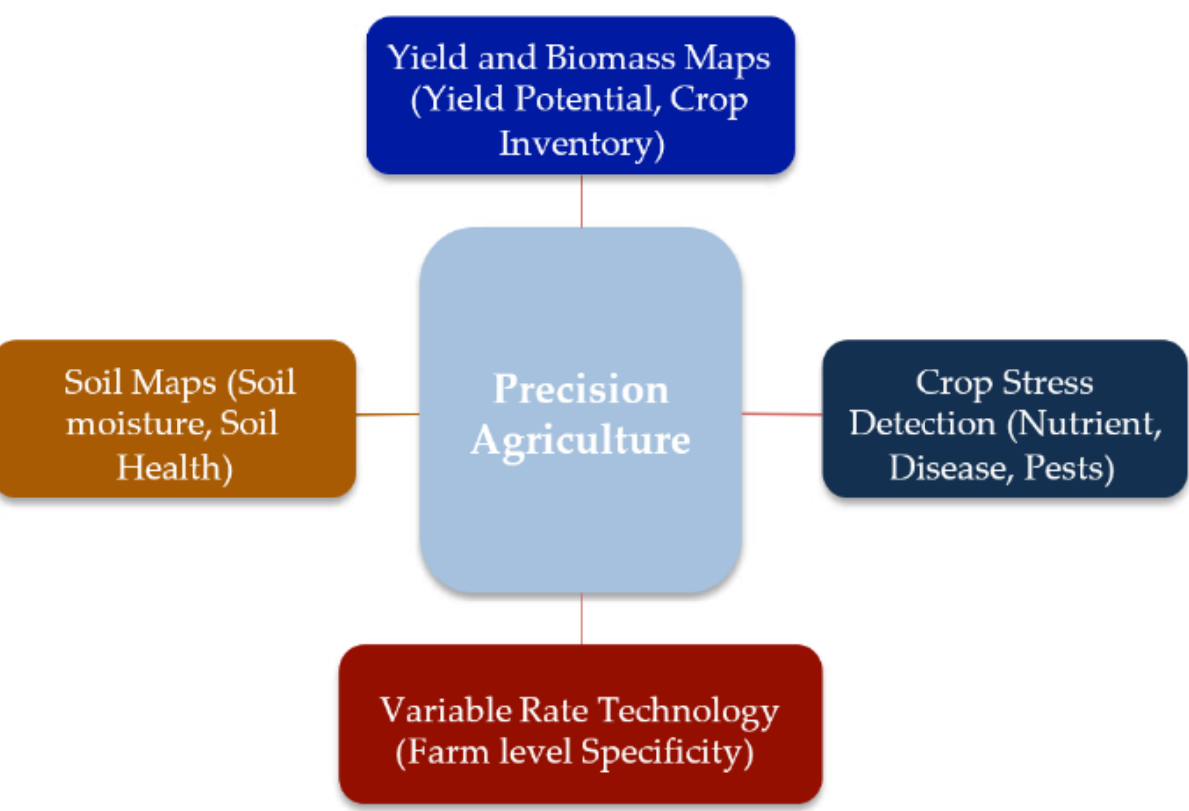
Figure 1. Flowchart depicting the precision agriculture operation cycle.